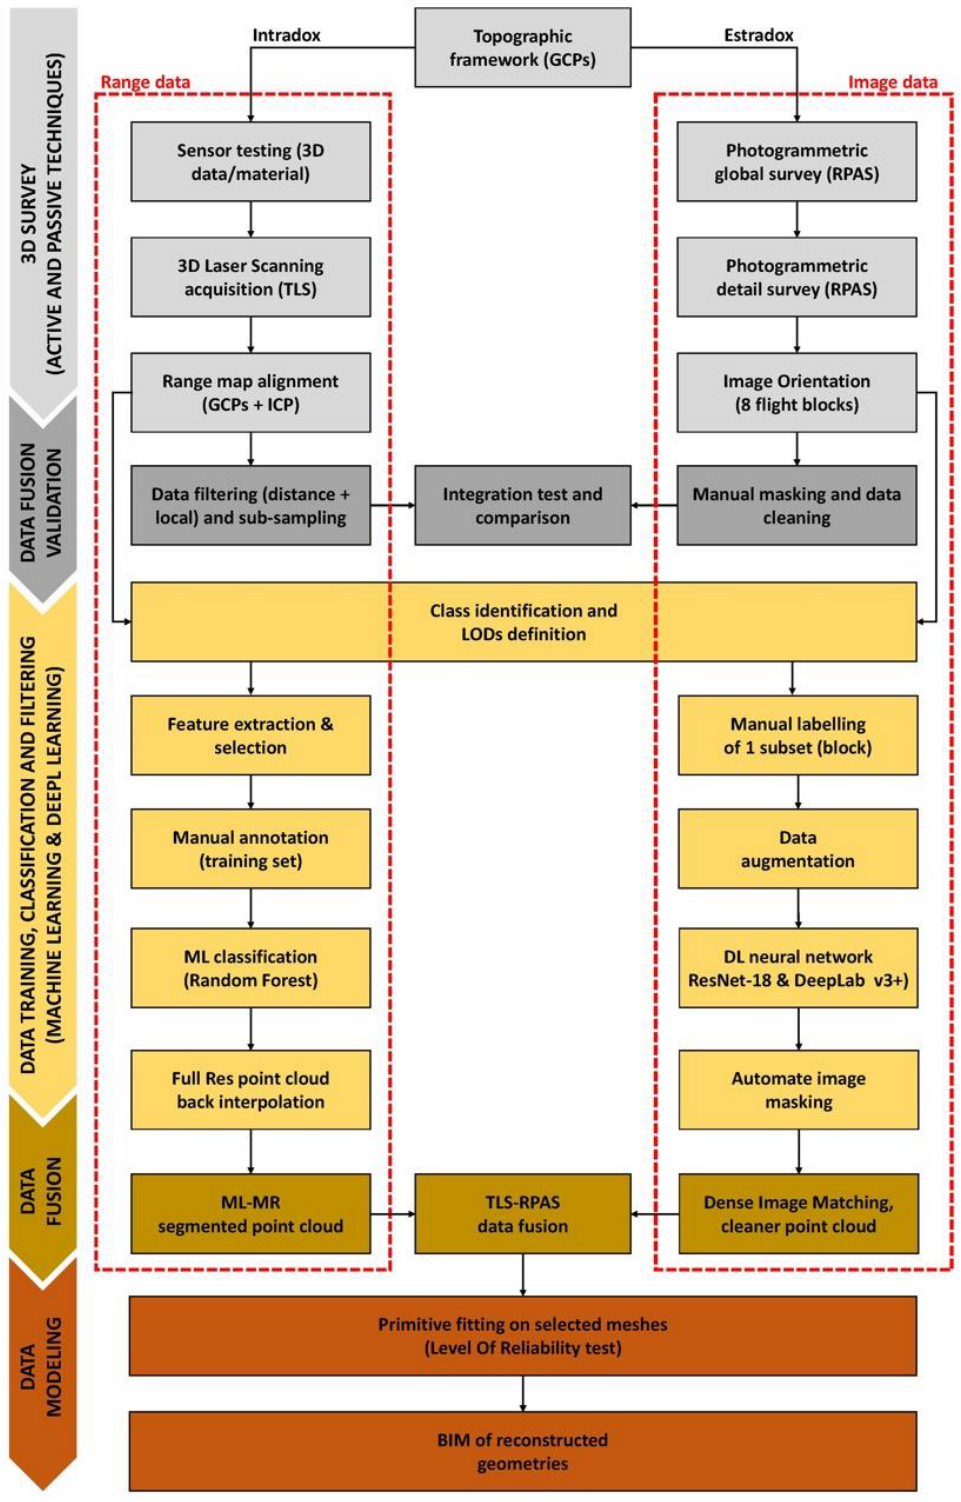
Figure 9. Research process pipeline highlighting the main development steps.